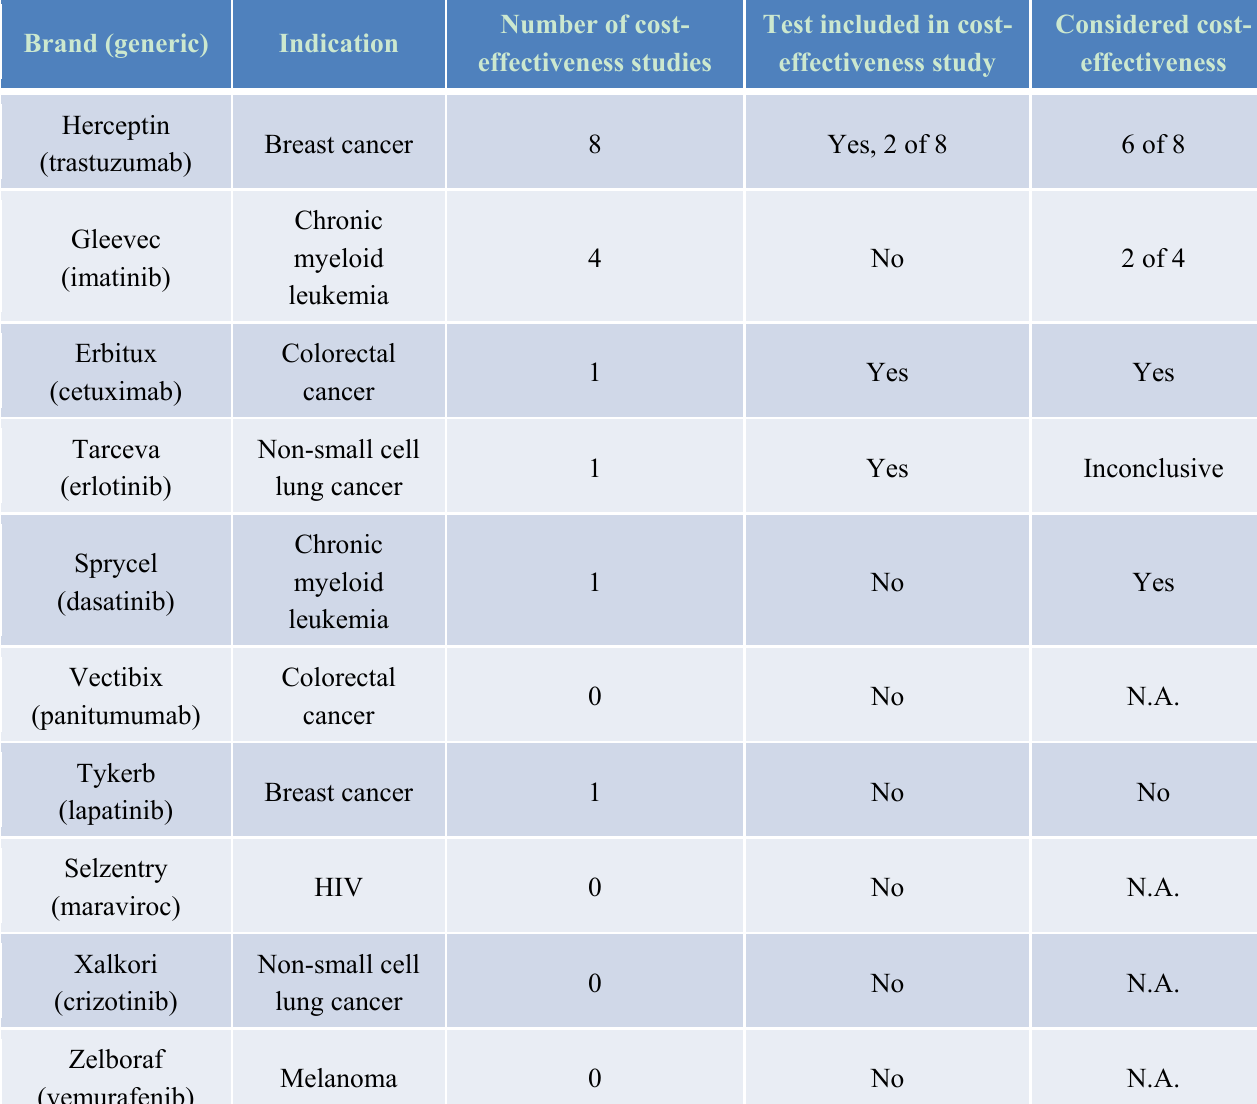
Table 5. Tufts cost-effectiveness registry